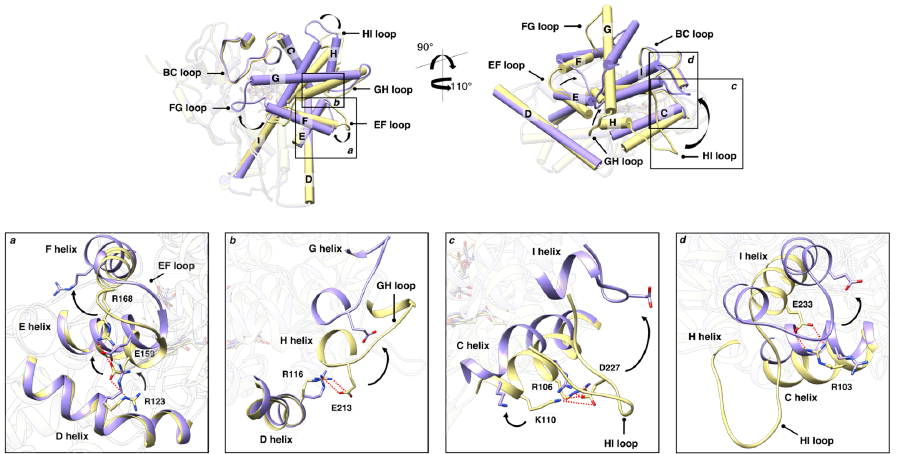
Figure 9. Putative ionic tethers in OleP. Top: open (yellow) and closed (purple) structures of OleP- 6DEB complex are superposed and shown in different orientations, highlighting the secondary structure elements mainly involved in the conformational change. Helices are represented as cylin- ders. Squared black boxes, named from ( a – d ), indicate the regions where the possible ionic tethers identified in OleP are located. Bottom: details of individual regions ( a – d ) and amino acids involved in intramolecular electrostatic interactions are represented. Red and green dashed lines represent electrostatic interactions found in the open and left in the closed structures, respectively. In all panels, arrows indicate the direction of the open-to-closed